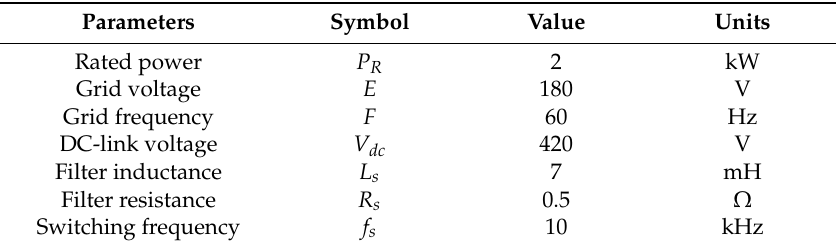
Table 2. System parameters of a grid-connected inverter.